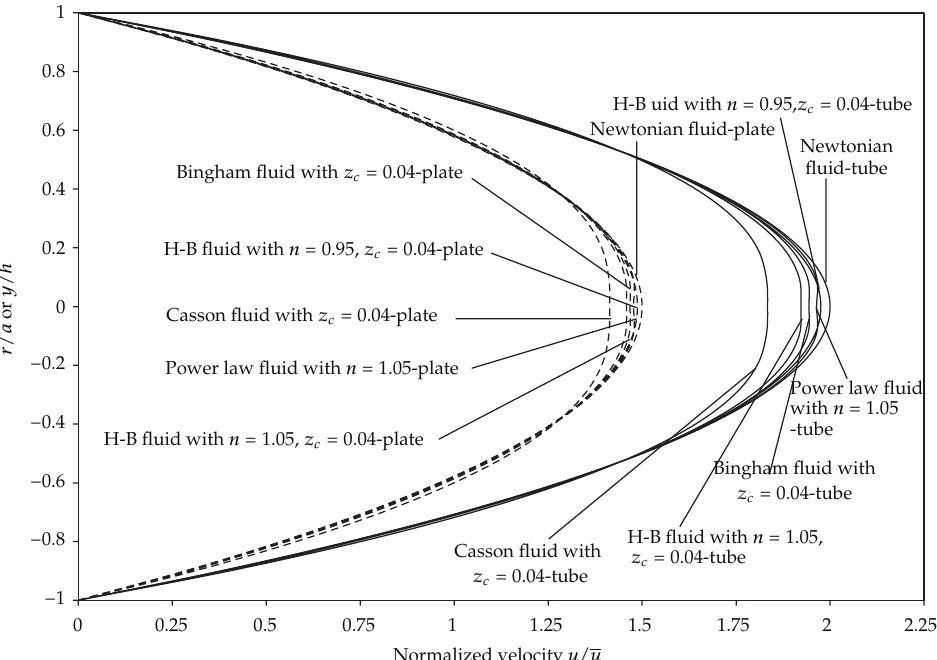
Figure 2: Normalized velocity profiles of some non-Newtonian fluids flowing in a tube and between parallel flat